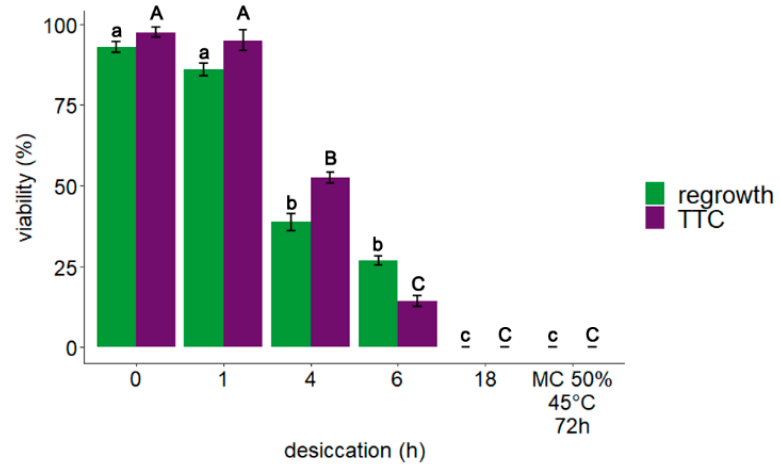
Figure 1. Effect of desiccation on Acer pseudoplatanus L. embryonic axes regrowth ( n = 5) and respiratory activity measured by TTC assay ( n = 4) [43]. The presented graph is supplemented with data obtained after storage of embryonic axes in accelerated aging conditions (72 h, 45 °C, MC of 50%). Statistical analyses were conducted on separate data sets. Capital and small letters correspond to analysis of TTC staining and tissue regrowth, respectively. Values labelled with different letters are significantly different at p ≤ 0.05, according to the Duncan test. Data represents mean ± SE.